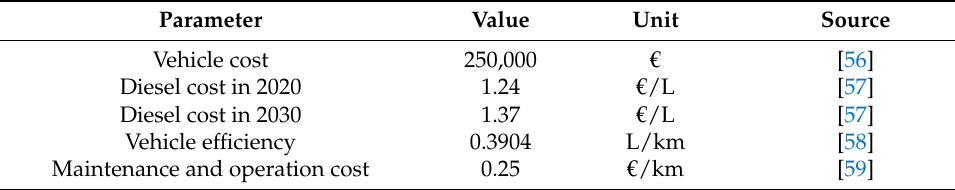
Table 10. Economical parameters for the diesel bus.